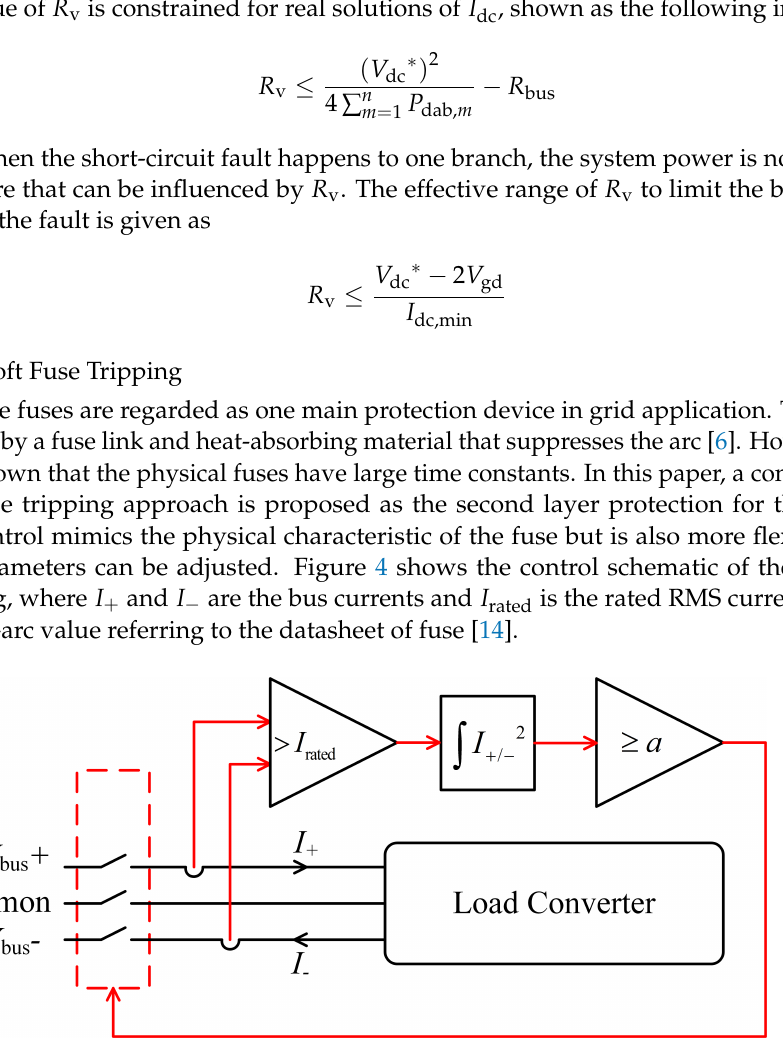
Figure 4. The control schematic of the soft fuse